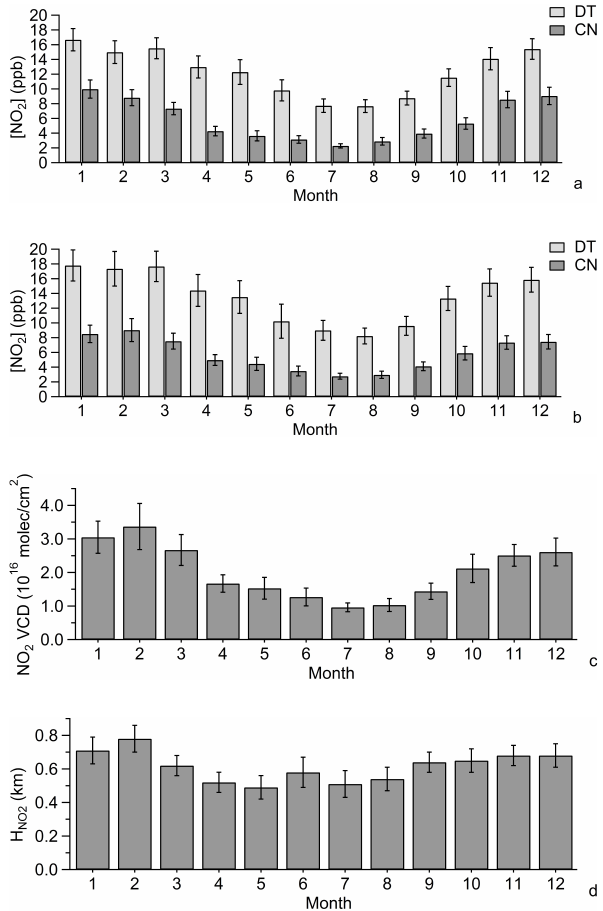
Fig. 3. (a) Monthly averaged in situ NO 2 concentration at DT and CN during the hours of 12:00–14:00EST for data meeting crite- ria 1–4 in Table 3 ( n =1181) and (b) for data meeting all criteria in Table 3 ( n =654). (c) Same as (b) but for in situ NO 2 VCD. (d) Same as (b) but for in situ NO 2 characteristic